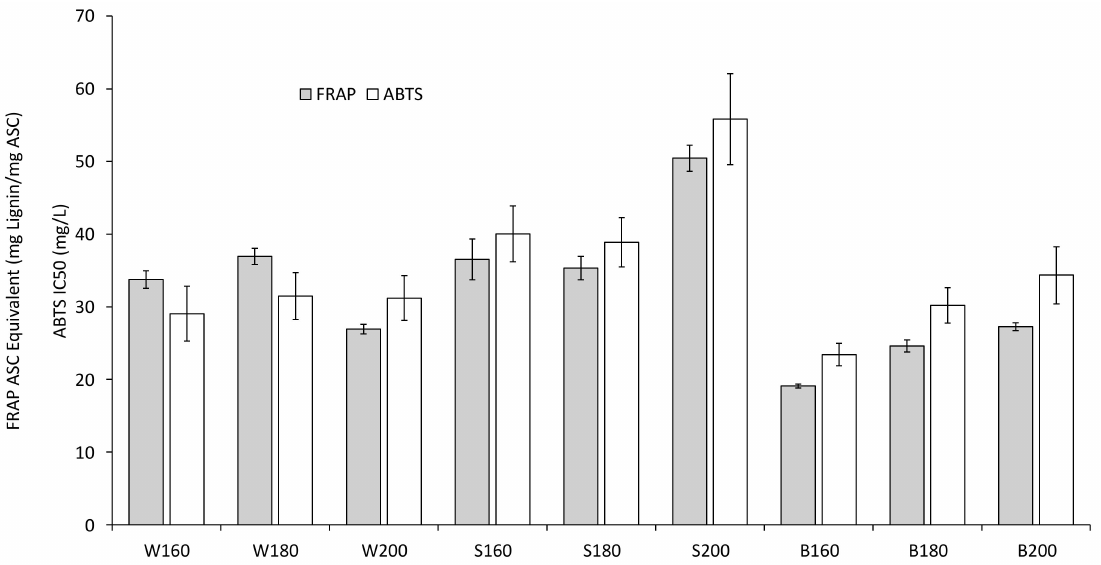
Figure 9. Antioxidant activities of particles after